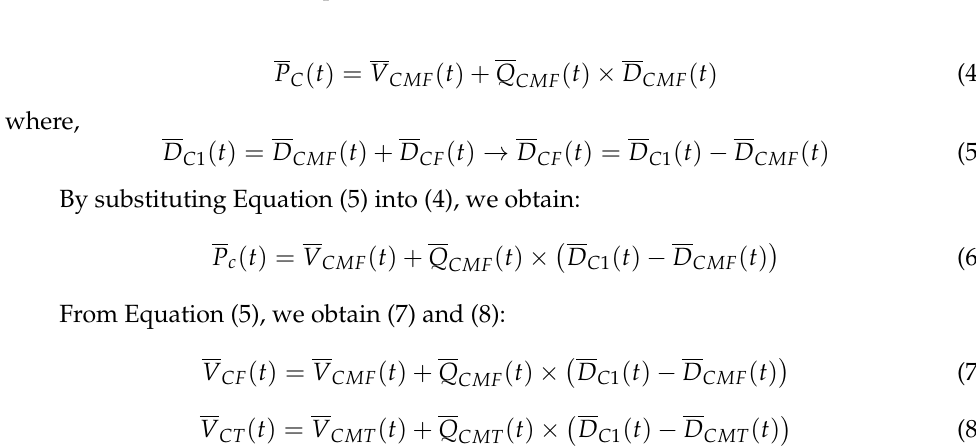
Figure 3. Kinematic of the knee prosthesis.